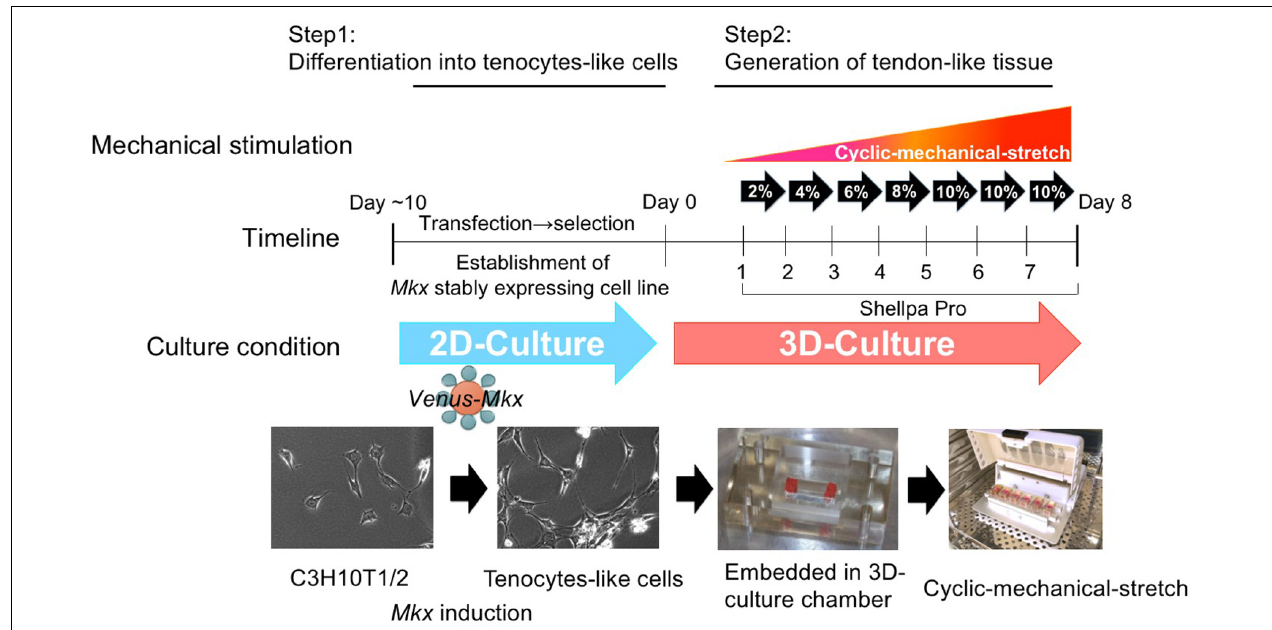
FIGURE 1 | The tendon/ligament-like tissue generation protocol. Schematic illustration of the tendon/ligament-like tissue generation